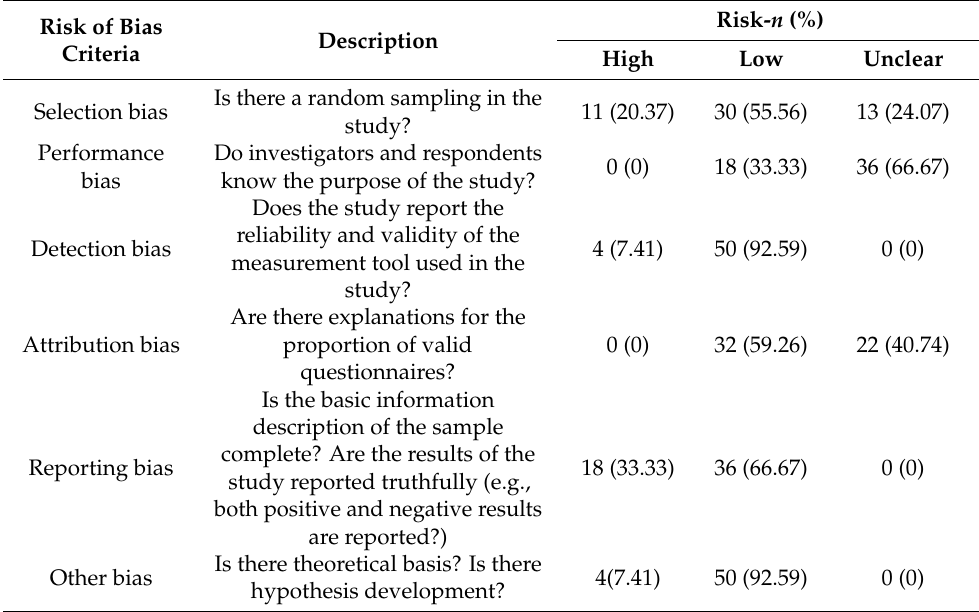
Table 1. Risk of bias assessment of 54 eligible articles included in the